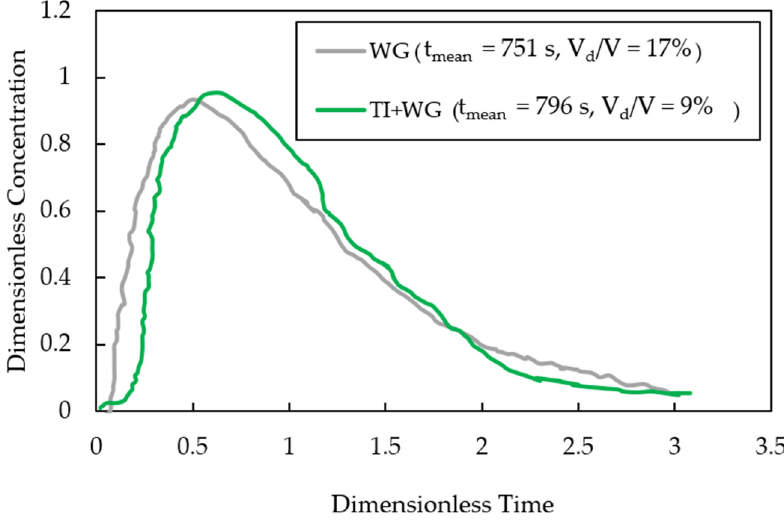
Figure 8. Comparison of measured RTD curves between two cases: WG and TI + WG (Theoretical residence time = 834 s).